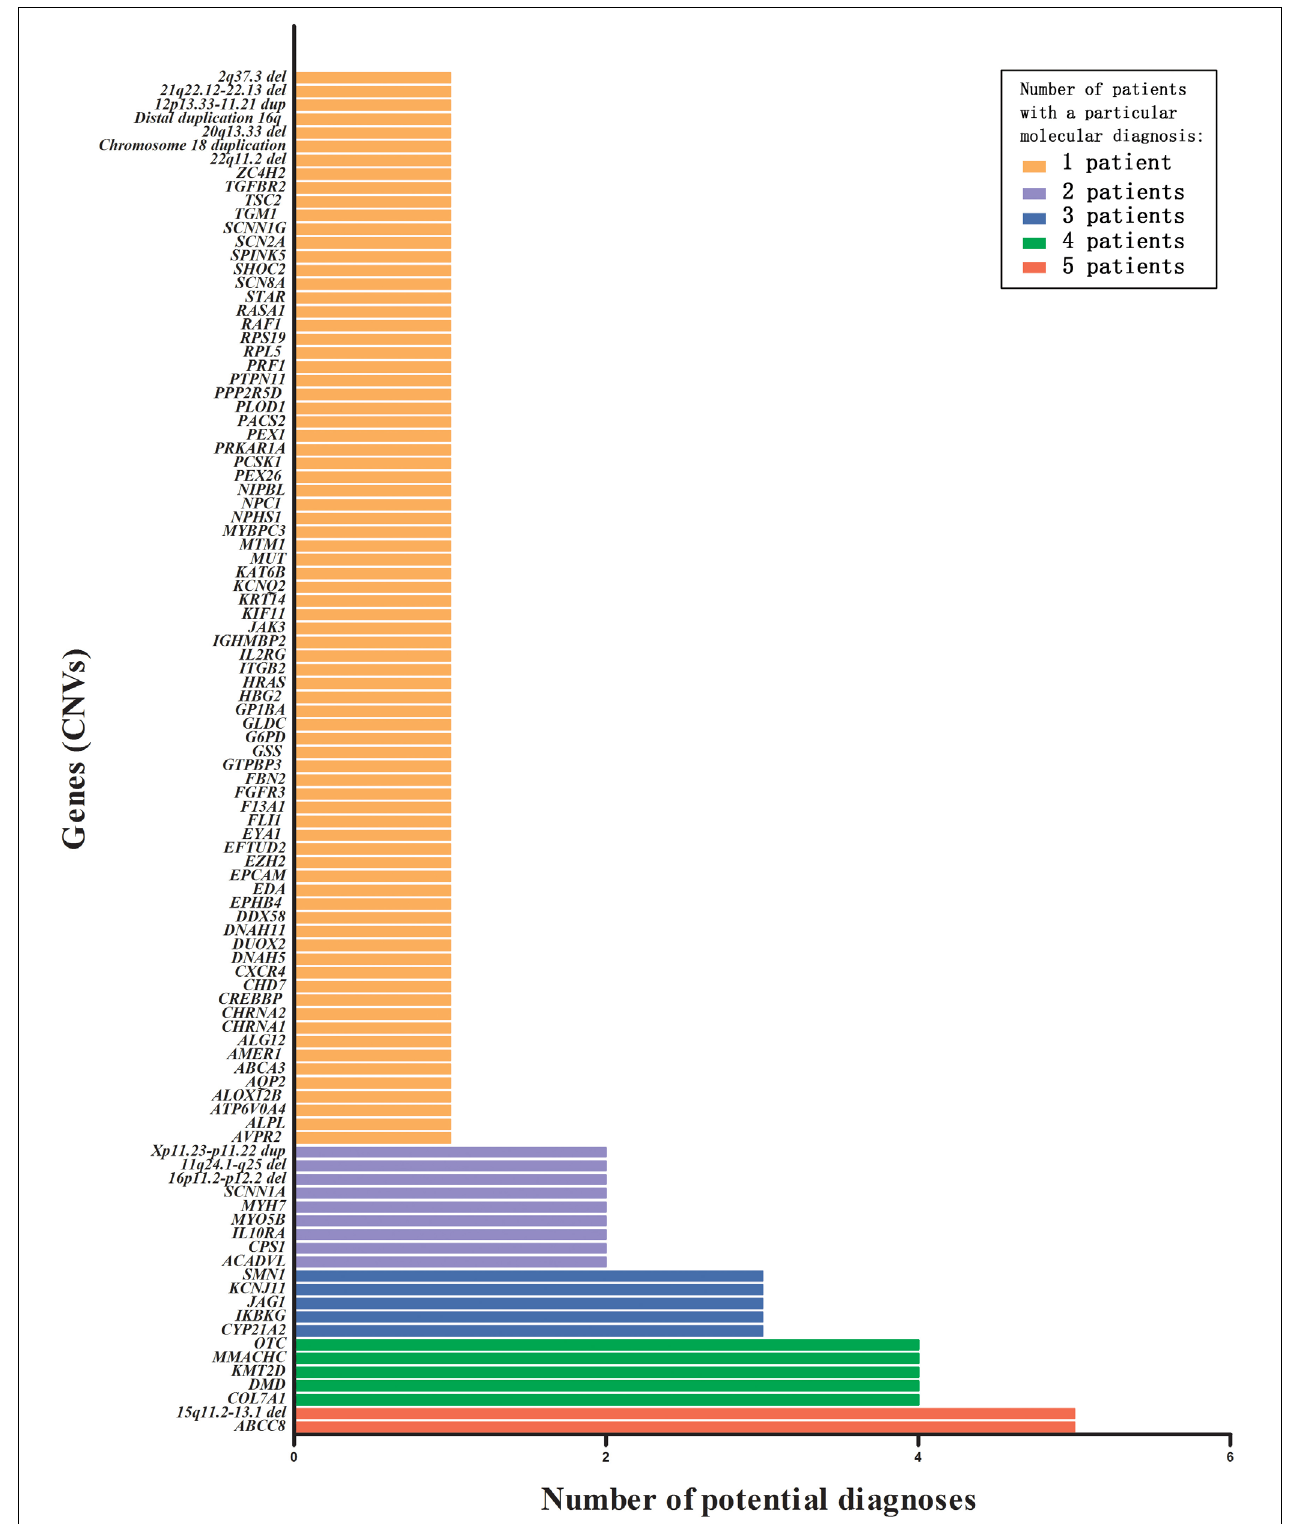
FIGURE 3 | Number of potential diagnoses that were tested by various TES panels or WES, for all genes (including CNVs) with a pathogenic or likely pathogenic variant. TES, targeted exome sequencing; WES, whole-exome sequencing; CNV, copy number variations.